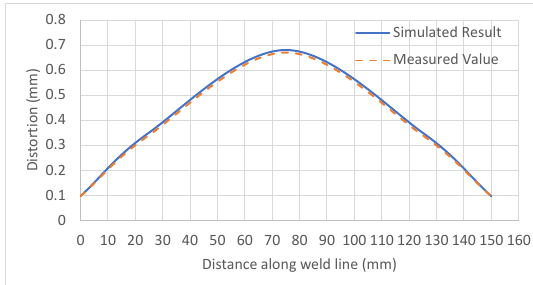
Figure 13. The weld sample for validation .